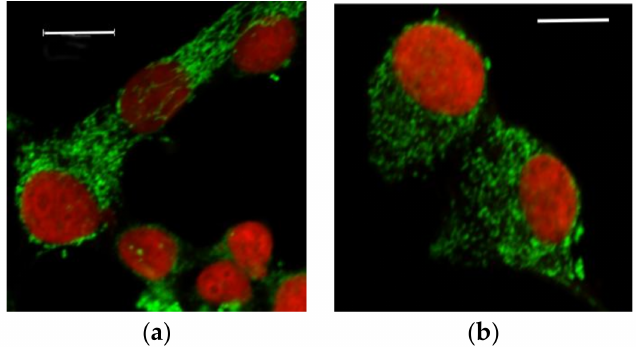
Figure 3. Selected images showing the effect of sub-lethal doses of cadmium on INS-1 cells mitochondria. Mitochondrial morphology was followed by staining a mitochondrial protein of the matrix, aconitase (green). The nucleus was stained by PI (red). INS-1 cells were treated for 96 h with ( a ) 0 and ( b ) 2 µ M CdCl 2 . Scale bars 10 µ